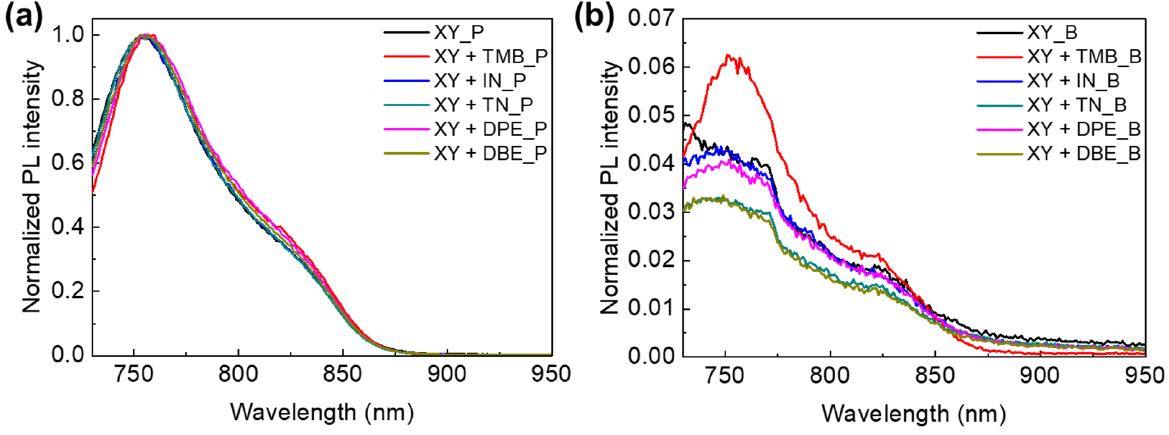
Figure 11. Photoluminescence spectra for ( a ) p ‐ type polymer films and ( b ) blend polymer